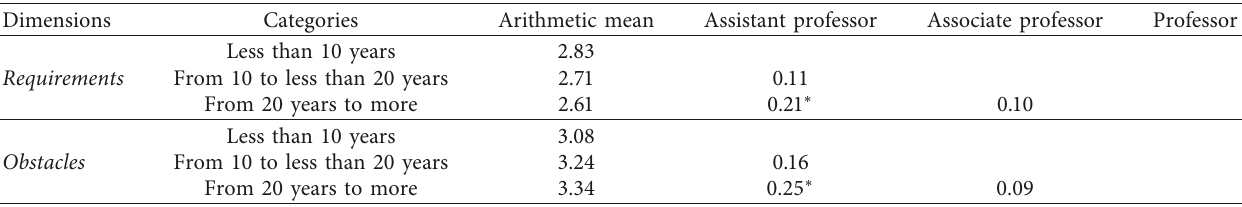
Table 15: Dimensional comparisons using (Scheff´e) way of the experience impact requirements, obstacles, and proposed solutions to overcome distance education obstacles in the face of university educational crises.